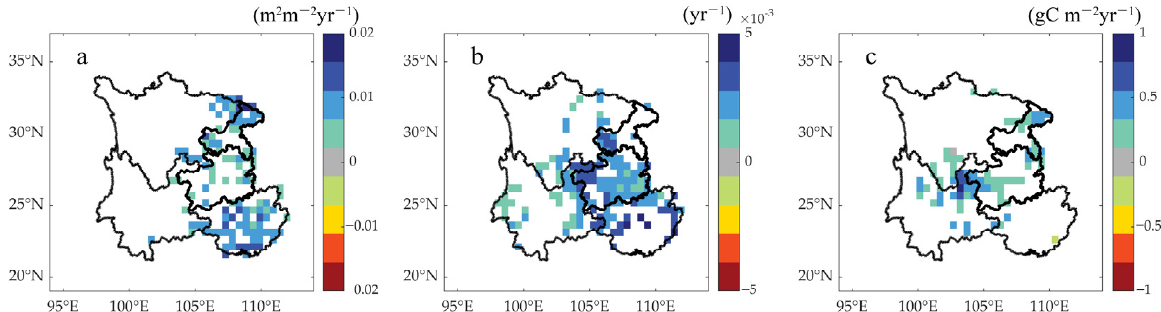
Figure 10. The annual trend regression residuals of vegetation indicators, temperature, and precipitation. ( a – c ) represent LAI, EVI, and GPP respectively; all pixels that do not meet the prerequisites ( R 2 > 0.3, p < 0.05) and the residuals that are not significant have been